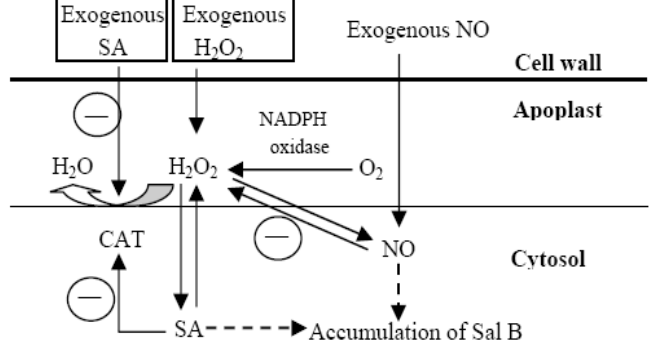
Figure 6. A proposed schematic illustration of H Salvia miltiorrhiza cell cultures. The circled “—” shows negative regulation. SA: salicylic acid; CAT: catalase; NO: nitric oxide; Sal B: salvianolic acid